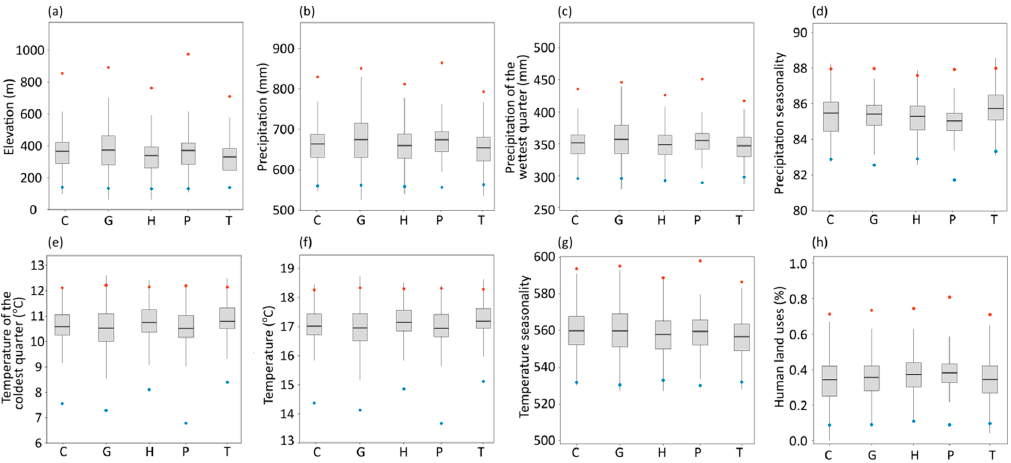
Figure 2. Boxplots of elevational ( a ) and environmental ranges ( b–h ) of different life forms in the island of Crete. The horizontal line denotes the mean values, the box indicates the first and third quartiles, and the red and blue points the maximum and minimum values, respectively. Life forms abbreviations: C = chamaephytes, G = geophytes, H = hemicryptophytes, P = phanerophytes, T = therophytes.